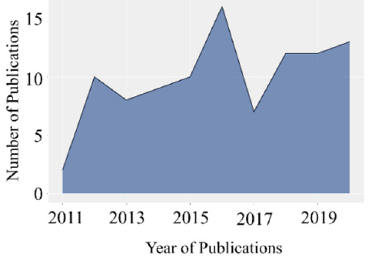
Figure 12. Annual Scientific Production (ROA).